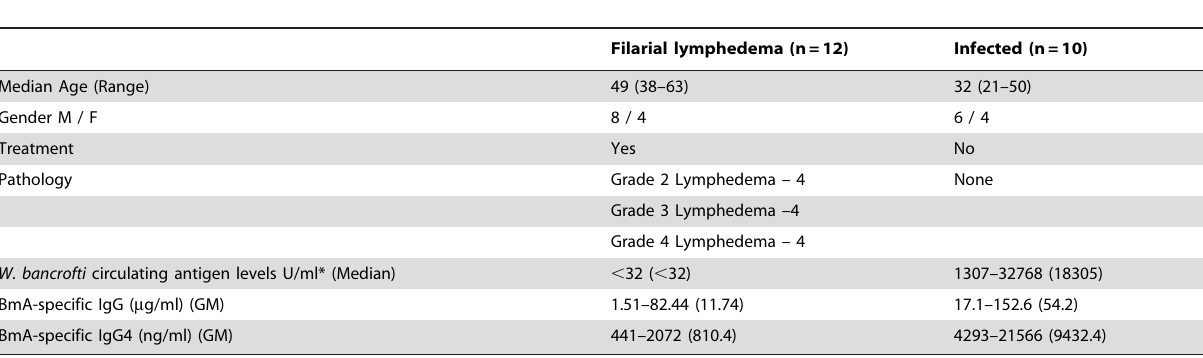
Table 1. Characteristics of the study